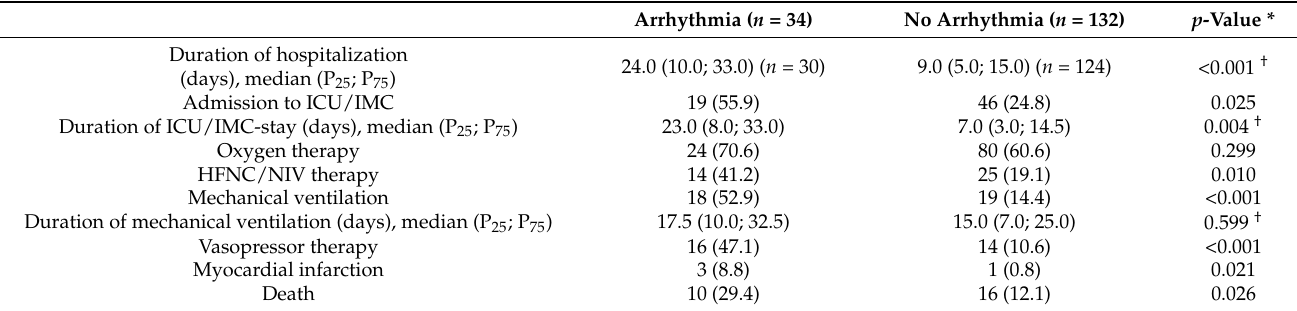
Table 3. In-hospital events and clinical